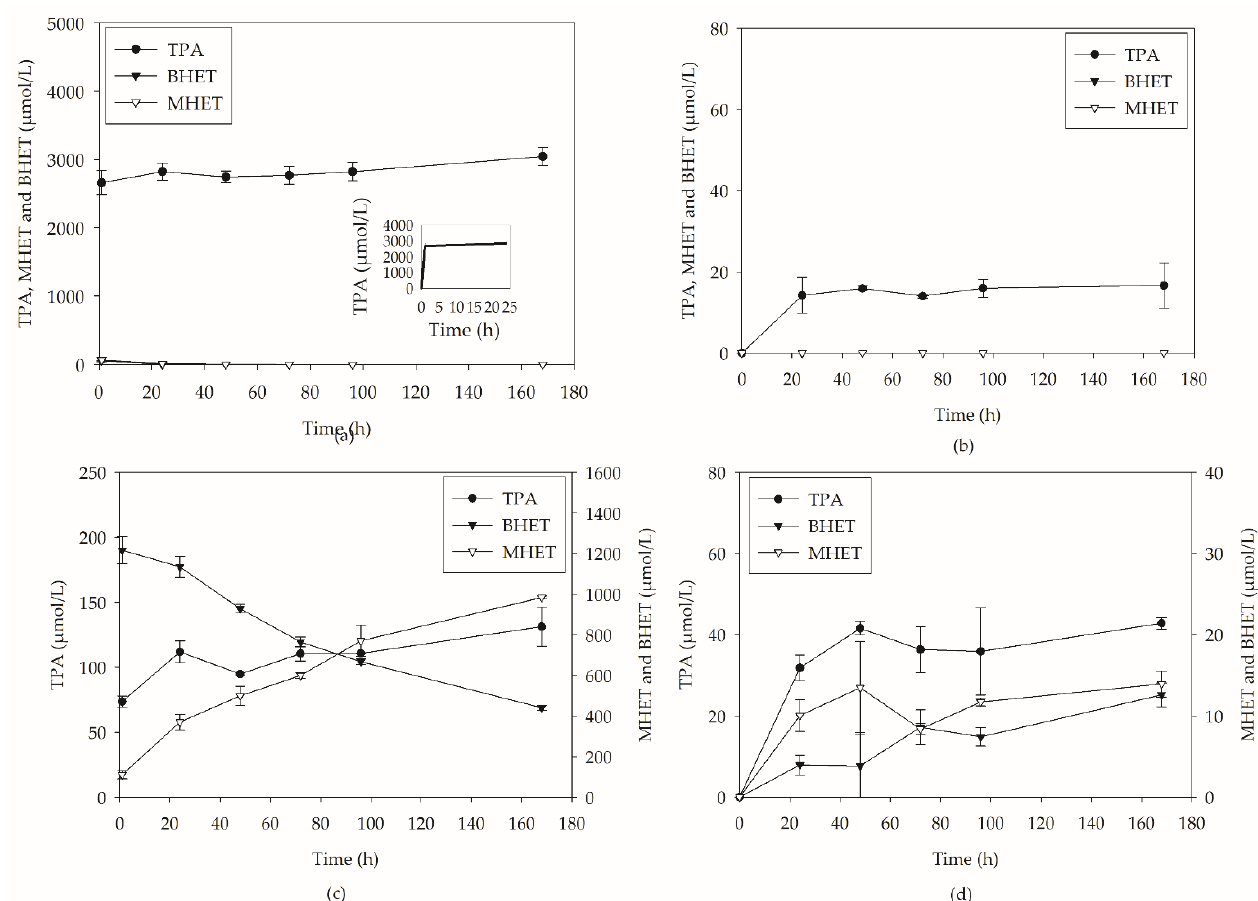
Figure 1 . Enzymatic hydrolysis of BHET using: ( a ) CALB and ( b ) SSF-YL and PC-PET using: ( c ) CALB and ( d ) SSF-YL at 37 °C and 180 rpm. Table 1. Molar fractions after 168 h of reaction using BHET and PC-PET as hydrolysis substrates at 37 ◦ C and 180